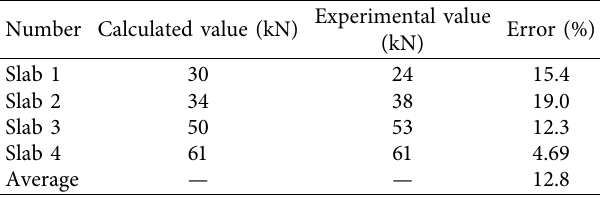
Table 7: Comparison of theoretical and experimental cracking load